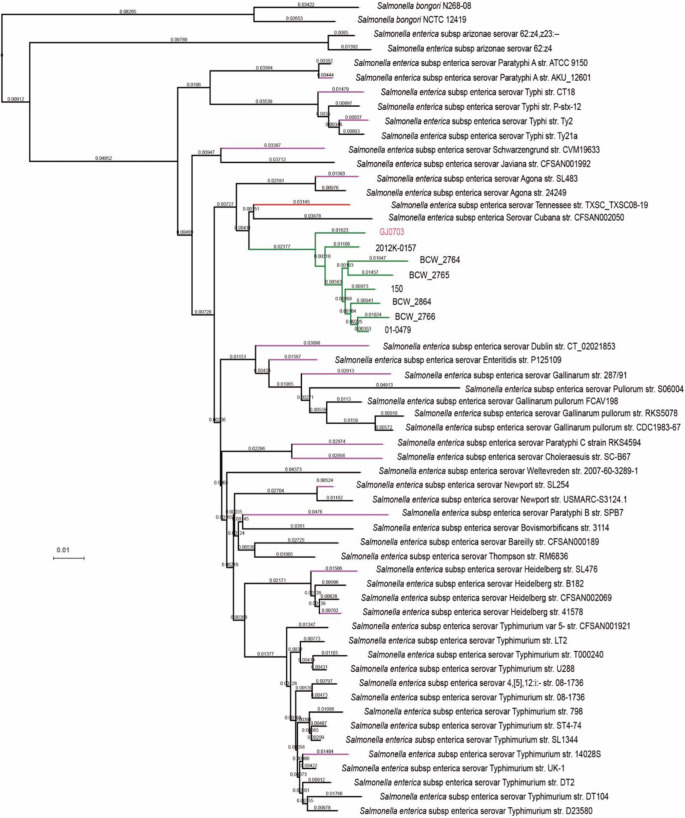
Phylogeny of S. enterica Rissen GJ0703 and available Salmonella genomes. The GJ0703 genome and other Rissen strains constitute a compact group (green) in this tree and this clade is closely connected with serovar Tennessee strains. Sixteen reference Salmonella genomes listed in Table S1 was indicated by purple. Phylogenetic relationships were inferred by CVTree3 (available at tlife.fudan.edu.cn/cvtree), and evolutionary distances were denoted close to the phylogenetic clades.